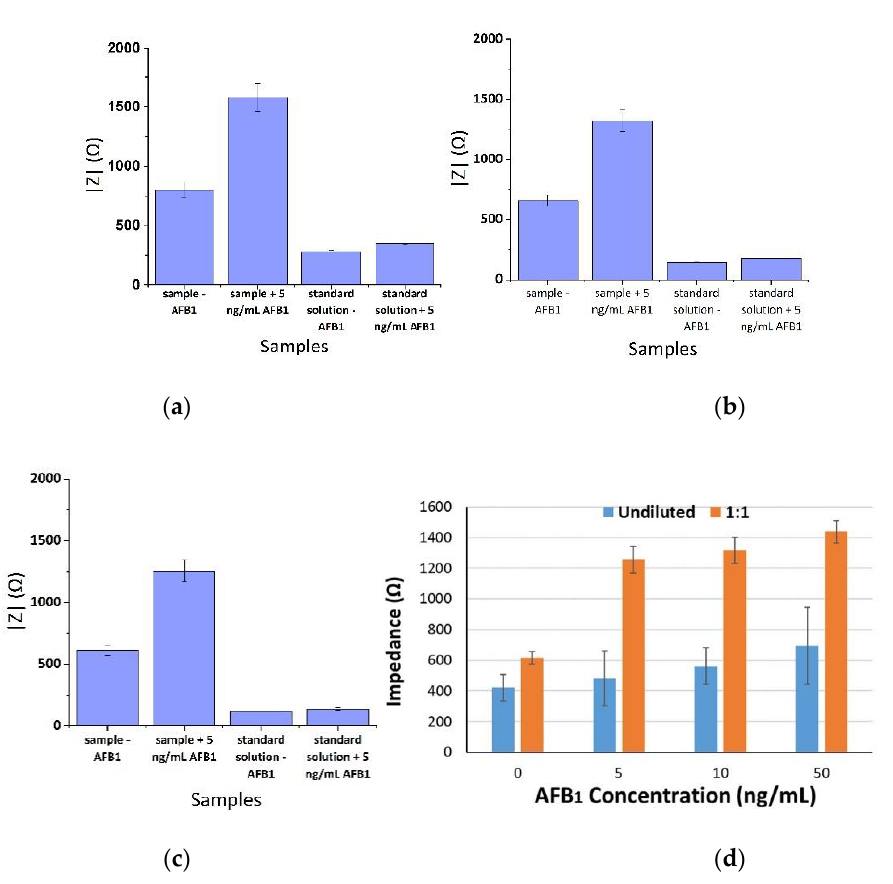
Figure 5. Extracted results from the mean impedance magnitude values for standard buffered solutions and pistachio extracts with and without the addition of AFB 1 at three frequencies ± STD: ( a ) 1 KHz, ( b ) 10 KHz and ( c ) 100 KHz. Biosensor’s results from undiluted samples and 1:1 dilution ( d ).